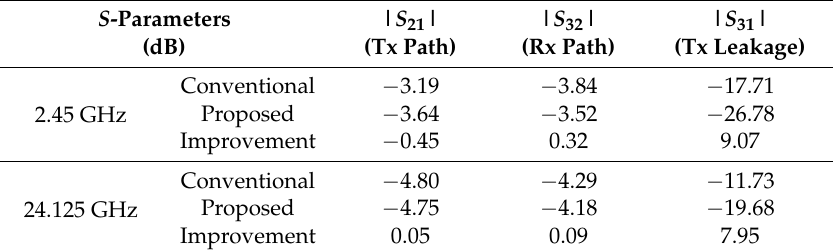
Table 1. Comparisons of the proposed quasi-circulators and the conventional quasi-circulators.